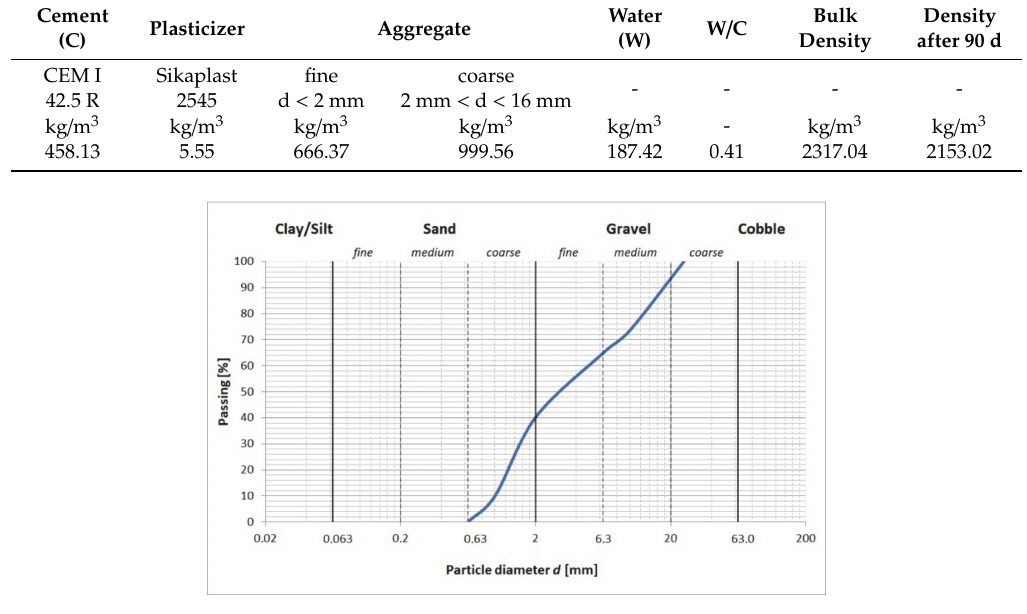
Figure 1. Particle size distribution of aggregates according to sieve